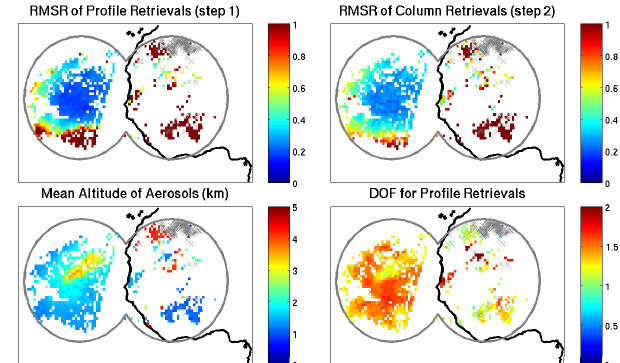
Fig. 6. Graphical representation of the retrieval strategy proposed in this work.